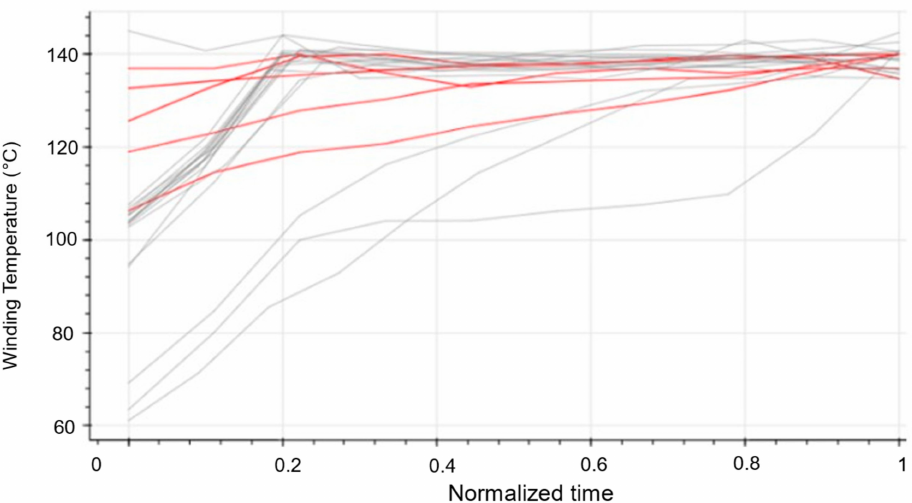
Figure 17. Stator winding temperature calculated by the DT thermal model from synthetic input variables (in grey). Stator winding temperature as measured by the SCADA system (in